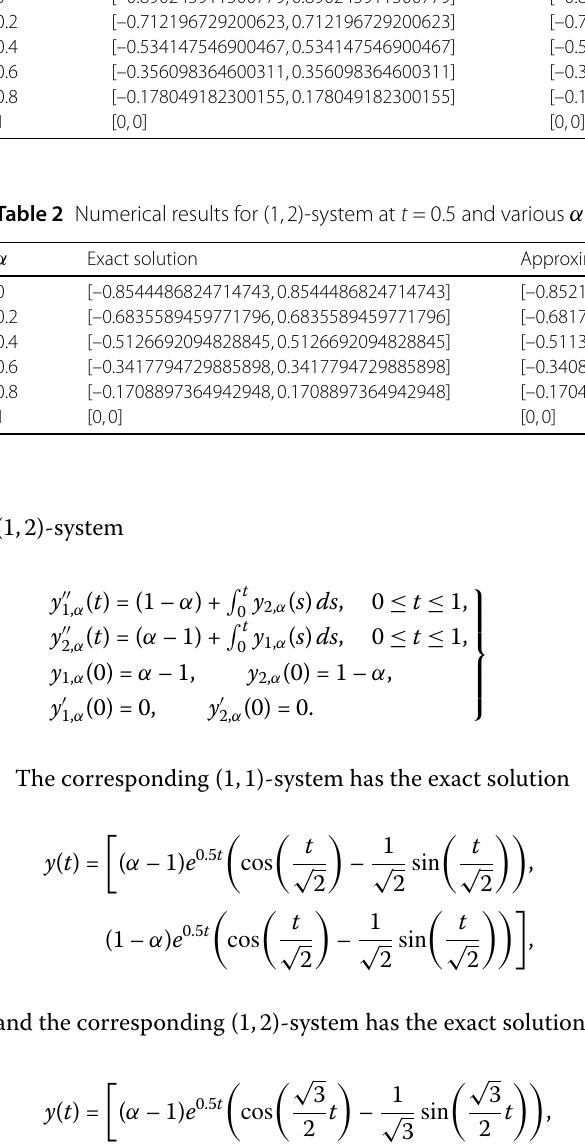
Table 1 Numerical results for (1,1)-system at t = 0.5 and various α α Exact solution